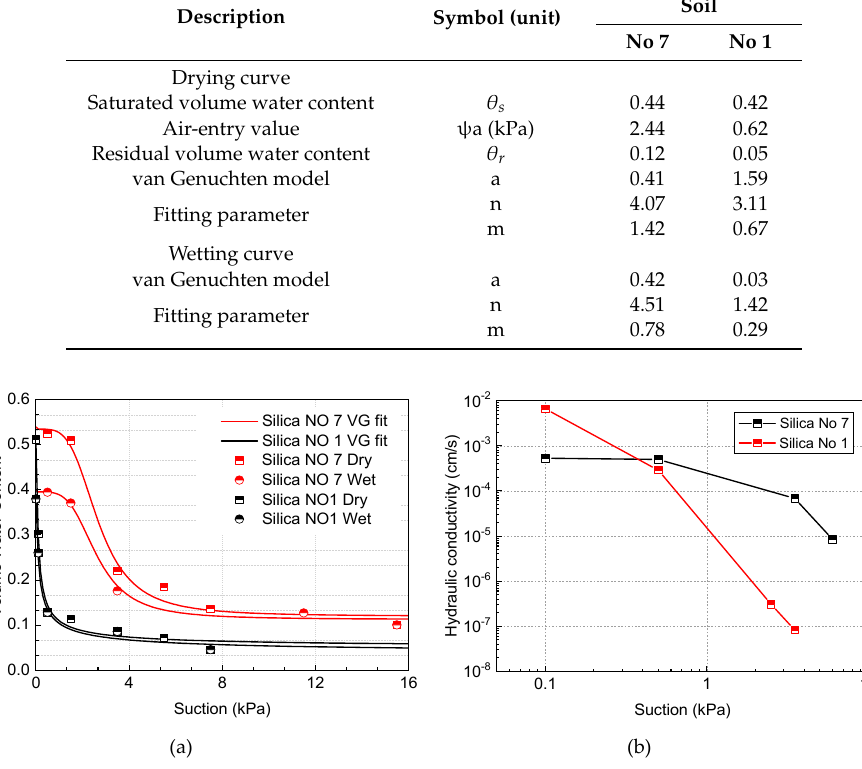
Figure 3. ( a ) Soil-water characteristic curves (SWCCs) of silica No 1 and No 7 in the drying and wetting process; ( b ) unsaturated hydraulic conductivity of silica No 1 and No 7 in the wetting